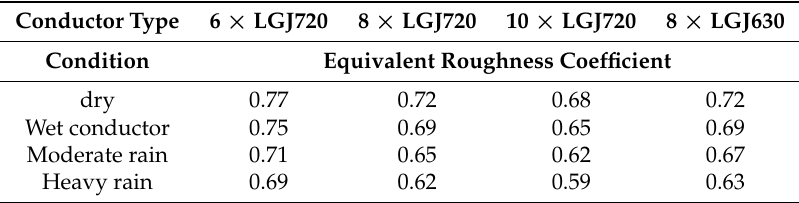
Table 9. Equivalent roughness coefficient under different weather conditions.